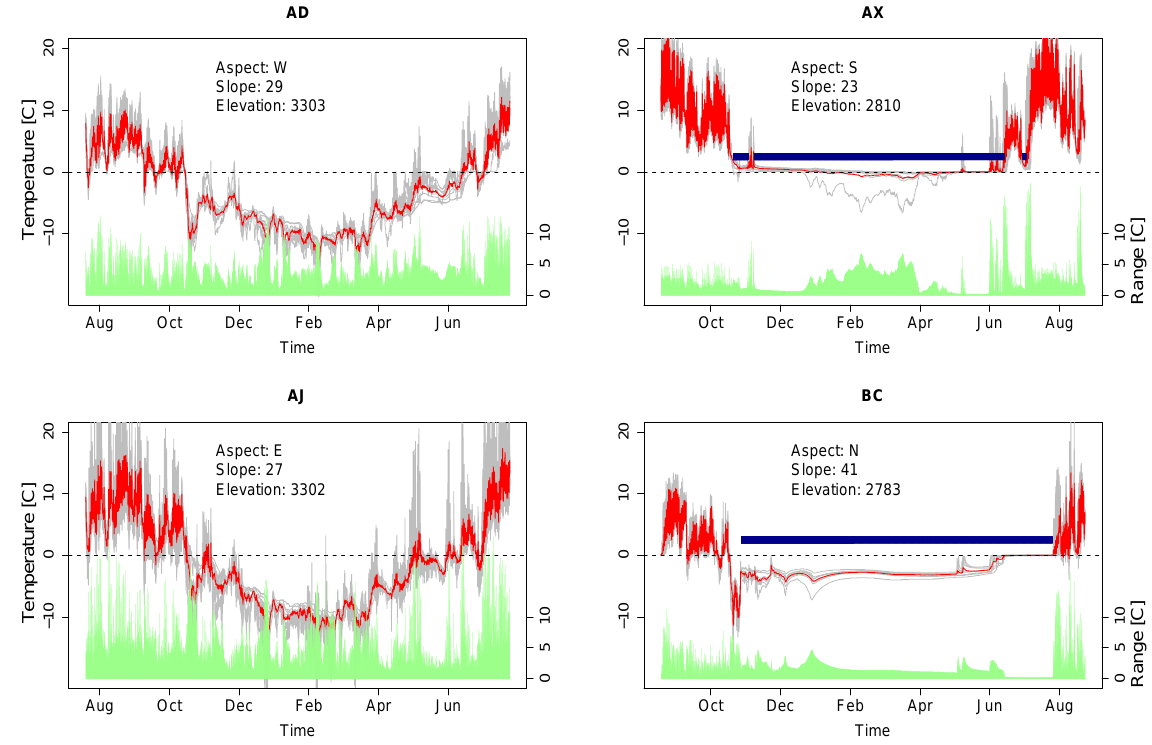
Fig. 5. GST of footprints AD, AJ, AX and BC. The grey lines in the background plot a maximum of ten iButtons located at the footprints. The red line indicates the mean GST at each time step. At the bottom of each plot, the range of all iButtons is plotted, indicating the temperature variability within each footprint. Snow cover is indicated in blue and was estimated manually based on daily temperature variations (Danby and Hik, 2007). Zero curtains can be identified at the end of the snow periods at AX and BC. tion according to the Akaike-Information-Criteria (Akaike, smallest threshold. When choosing a threshold of 0.125 ◦ C, 1973) combined with the addition of higher polynomials and interaction terms led to the model shown in Eq. (3). Note that sine and cosine of the aspect are taken to ensure con- tinuity. Since aspect is recorded from the north clockwise, cosine represents the dependence on north-south differences, and west-east differences are represented by the sine.